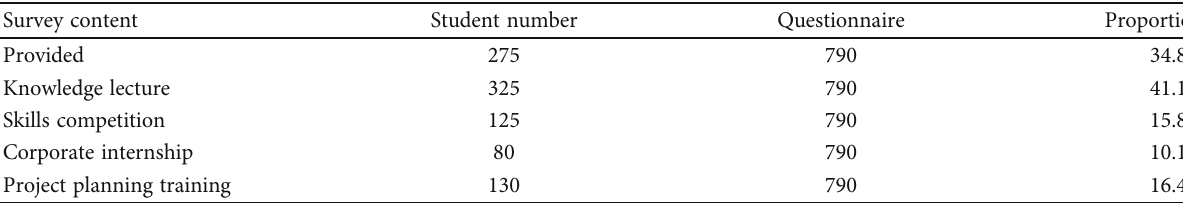
Table 3: Activities attended by college students.